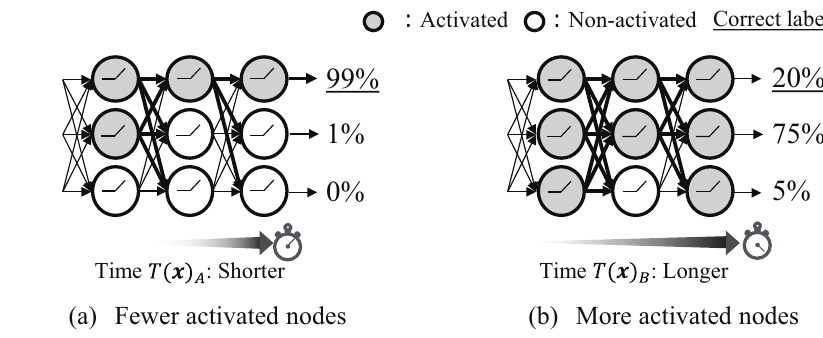
Figure 7: The attack concept against DNNs with ReLU functions is that these functions have longer processing times when the nodes are activated by the data-dependent timing leaks depending on the input data. Increasing the number of activated nodes affects the DNN output data because of the increasing number of propagated